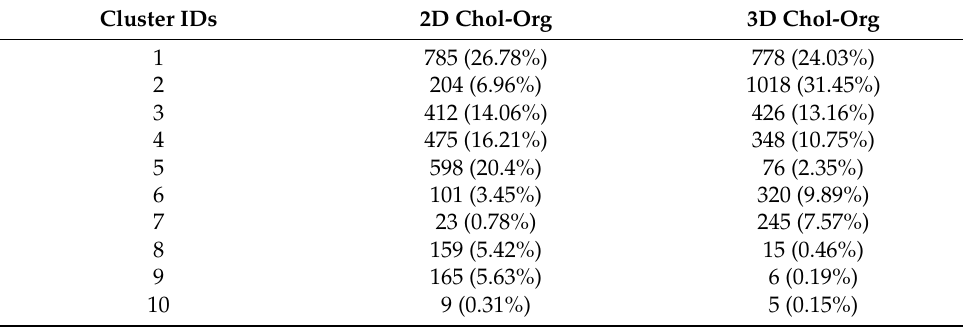
Figure 9. Violin plot showing prediction from singleCellNet for each cluster based on top 50 discrimi- nant genes and top 100 gene pairs derived from cell types from MacParland [22] dataset classifier model. All Clusters demonstrate a strong cholangiocytic signature. Table 2. The number and percentage of cells in each cluster and